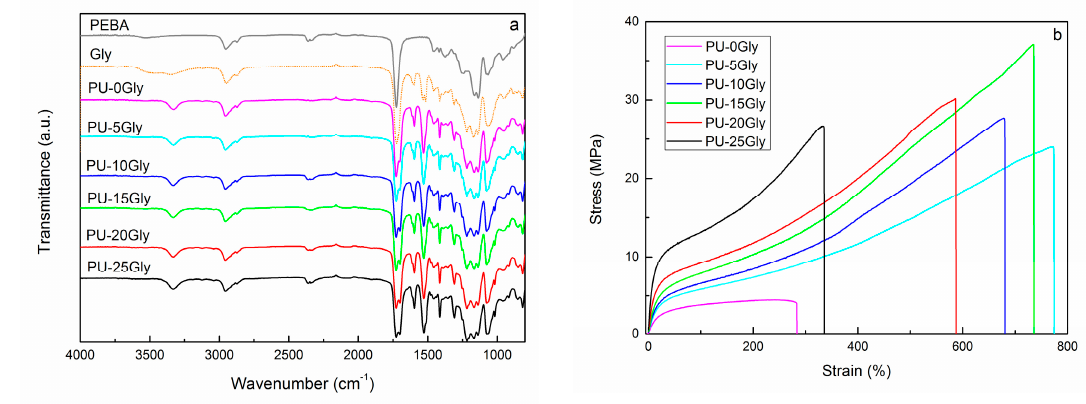
Figure 1. ( a ) FTIR spectra of Gly, PEBA and synthesized thermoplastic polyurethanes, and ( b ) tensile stress-strain curves of synthesized thermoplastic